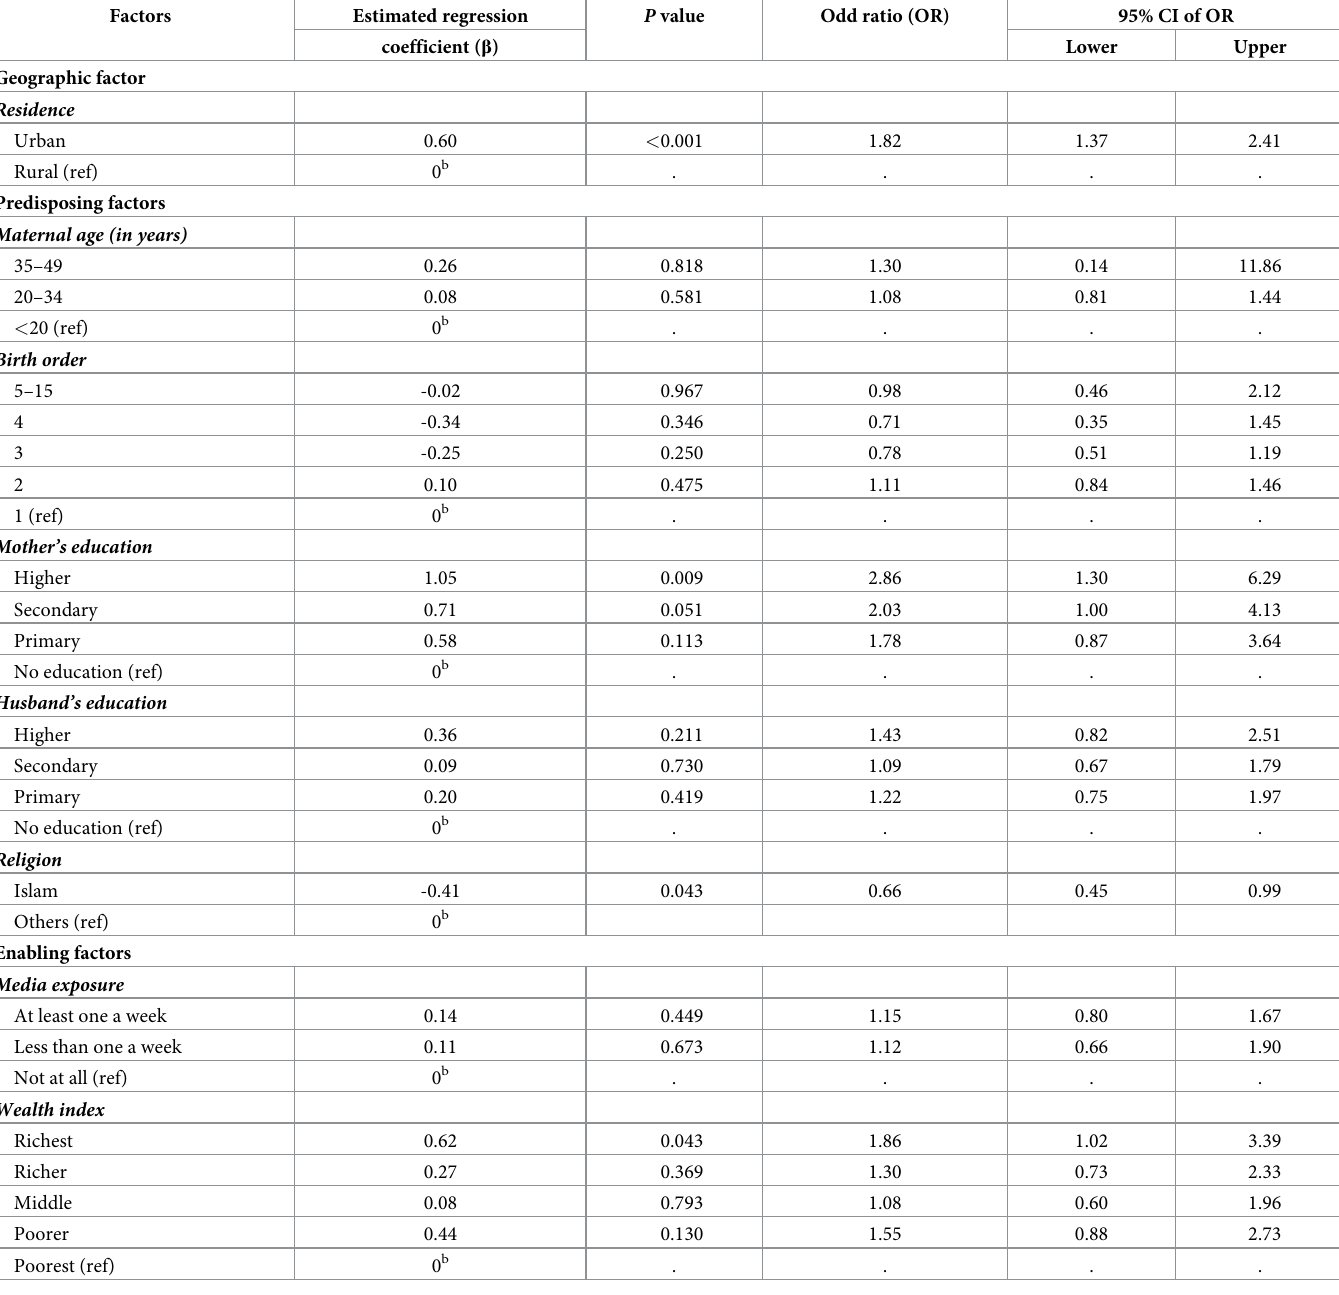
Table 3. Results of binary logistic regression to determine the factors influencing the WHO recommended � 8 ANC